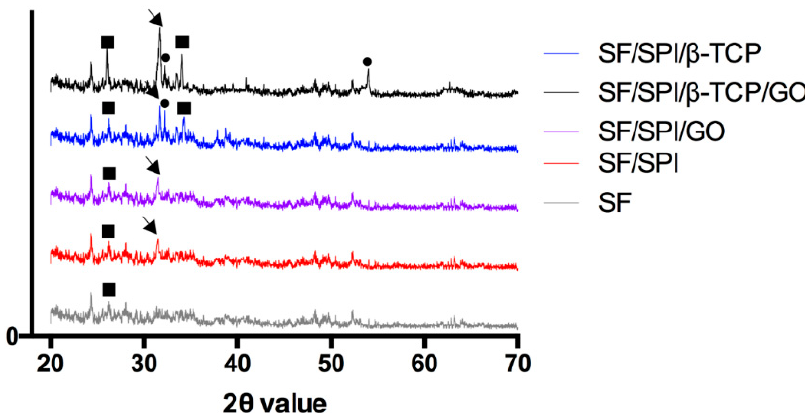
Figure 8. XRD patterns of the SF/SPI-based composite scaffolds after immersing into SBF solution for 14 days (circle refers to hydroxyapatite; arrow refers to apatite; square refers to β -TCP).